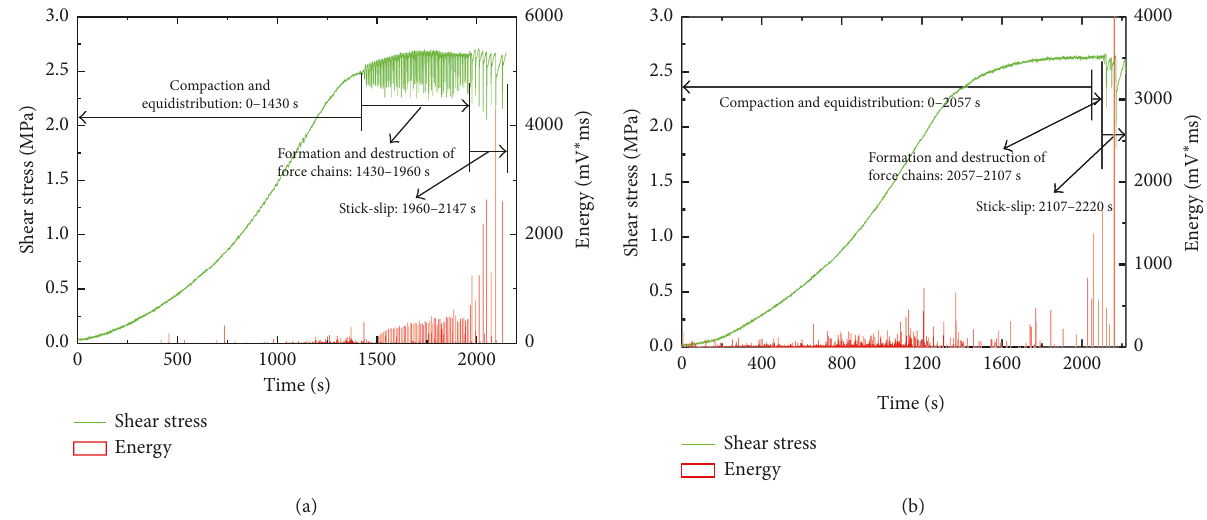
Figure 3: Variations of shear stress and AE energy of (a) Sample 1 and (b) Sample